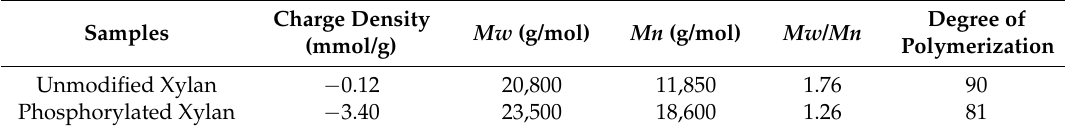
Table 3. The properties of unmodified xylan and phosphorylated xylan.